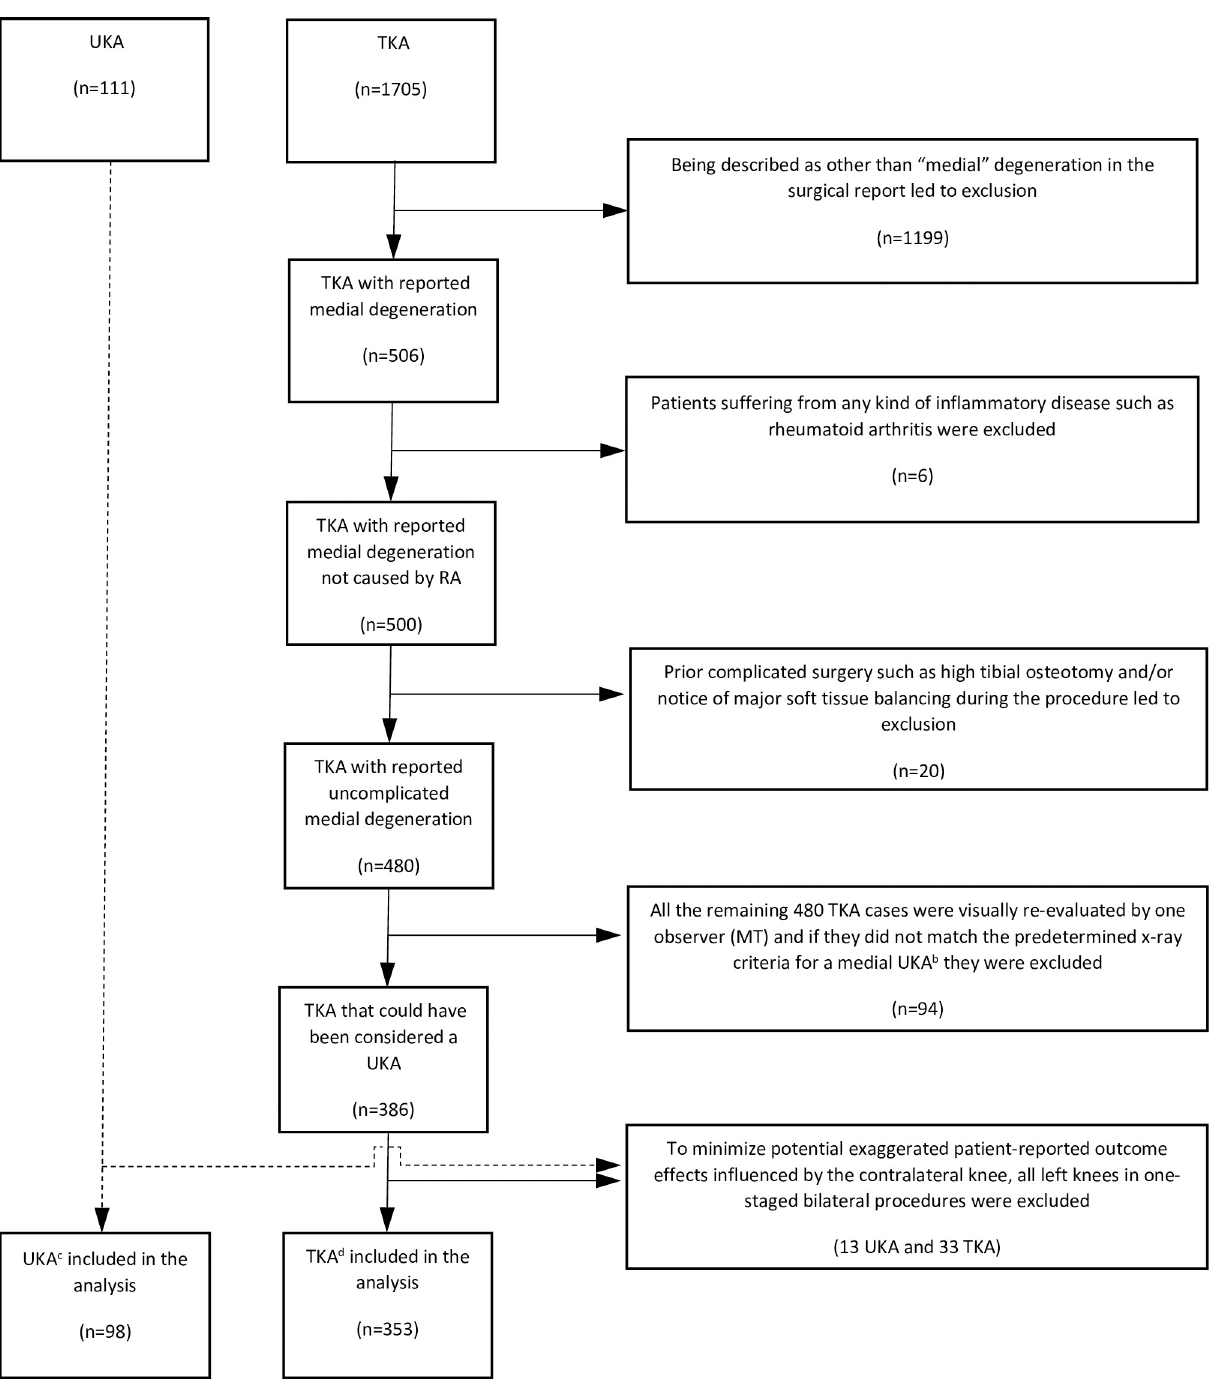
Fig 1. Flowchart of the 451 patients included in the study (and reasons for exclusion) a . a All the primary UKAs performed between 2015 and 2017 and all the primary TKAs performed in 2016 within Region Skåne , the southernmost county council of Sweden, were screened for eligibility. To the author´s knowledge, neither any gliding in indication nor altering of the surgical technique occurred during this timeframe. b In accordance with the 2D radiograph-based consensus criteria for medial UKA [21], the degeneration on the medial side should present bone-on-bone, have indirect signs of functionally intact ACL, and show full thickness cartilage in the lateral compartment, otherwise be excluded. (Additionally, in the absence of medial/ lateral stress x-rays, more than 15 degrees of varus deformity, translation in the coronal plane, and/or lateralization of the patella in the skyline projection also led to exclusion from further analyses in this study.). c 70 LINK 1 Sled prosthesis; 28 Triathlon 1 PKR, Stryker. d 318 Triathlon 1 , Stryker; 34 P.F. C. 1 Sigma 1 , DePuy Synthes; 1 Vanguard 1 XP, Zimmer-Biomet.